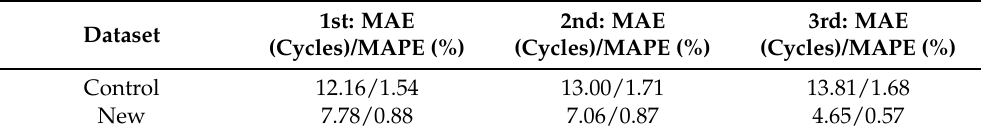
Table 1. Results for mean absolute error (MAE) and mean absolute percentage error (MAPE) from the ANN algorithm (1st: with raw data; 2nd: removing noise and peaks; 3rd: removing noise, peaks and the first cycle). The control dataset was compared against the dataset with newly added input features.